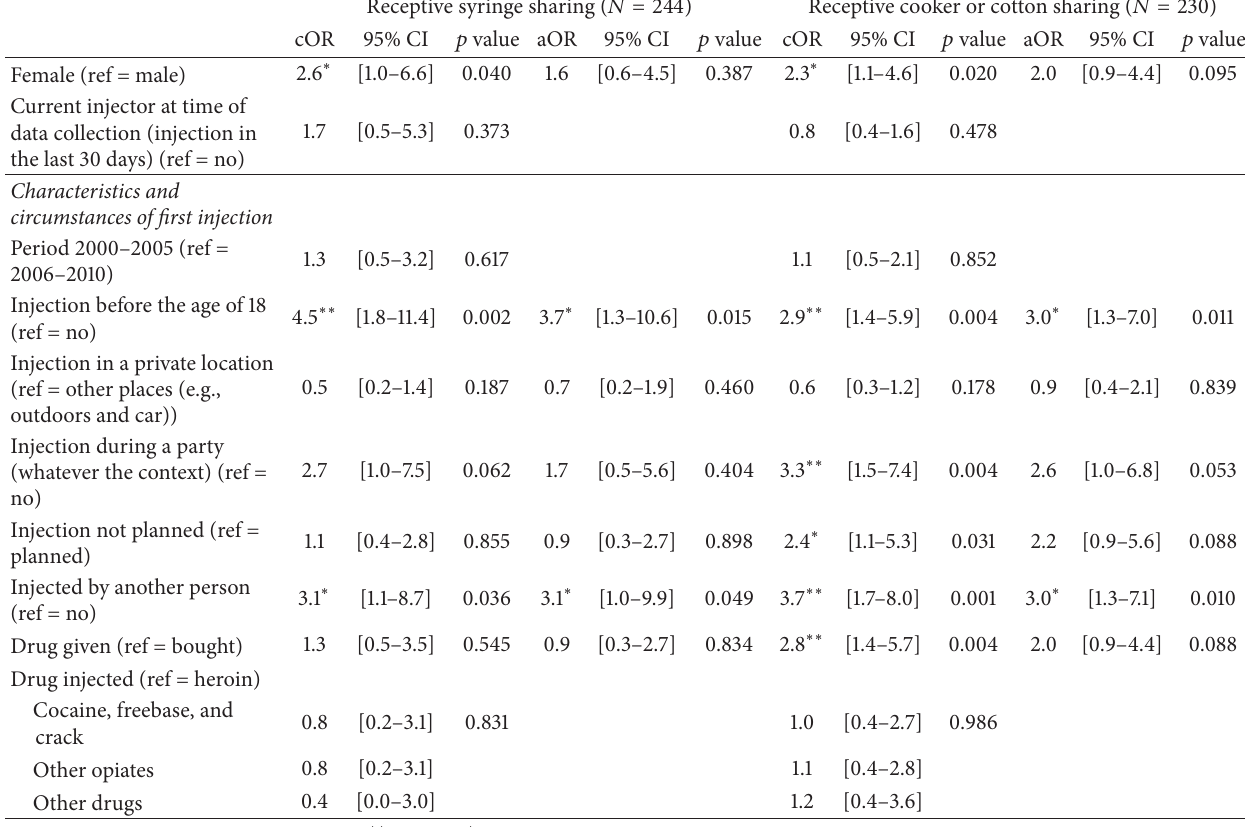
Table 2: Correlates of risk behaviours at time of first injection: crude odds ratios (cOR), adjusted odds ratios (aOR), and 95% confidence intervals